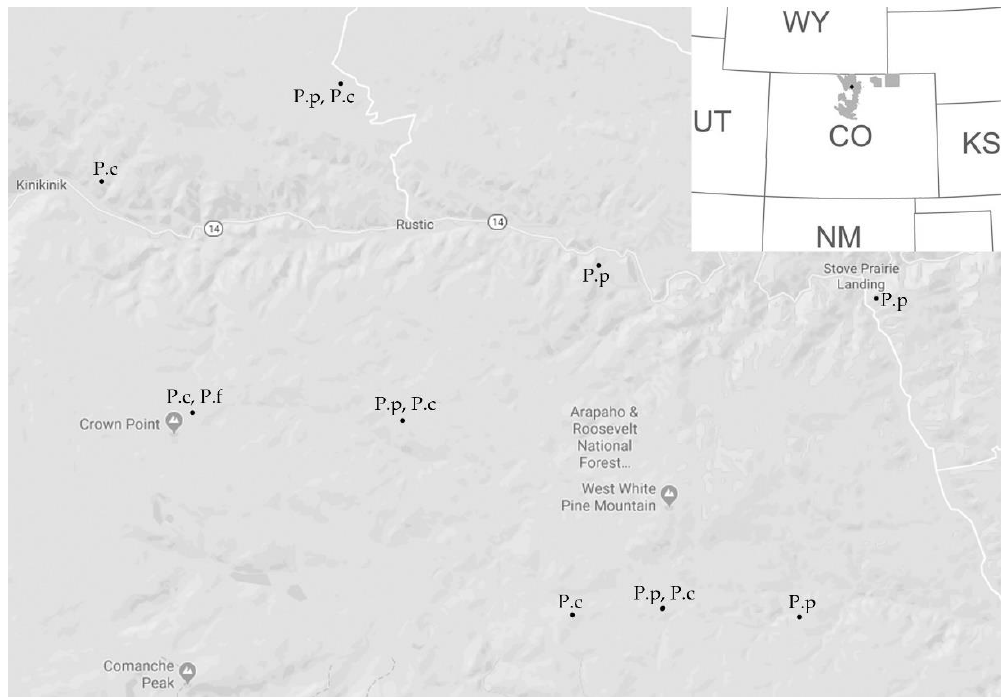
Figure 1. The map of study plots in P. ponderosa (P.p), P. contorta (P.c), and P. flexilis (P.f) dominated stands at the Roosevelt National Forest, Colorado, USA. The insert shows the location within the state of Colorado, U.S. The map is a terrain relief layer modified from Google Earth.